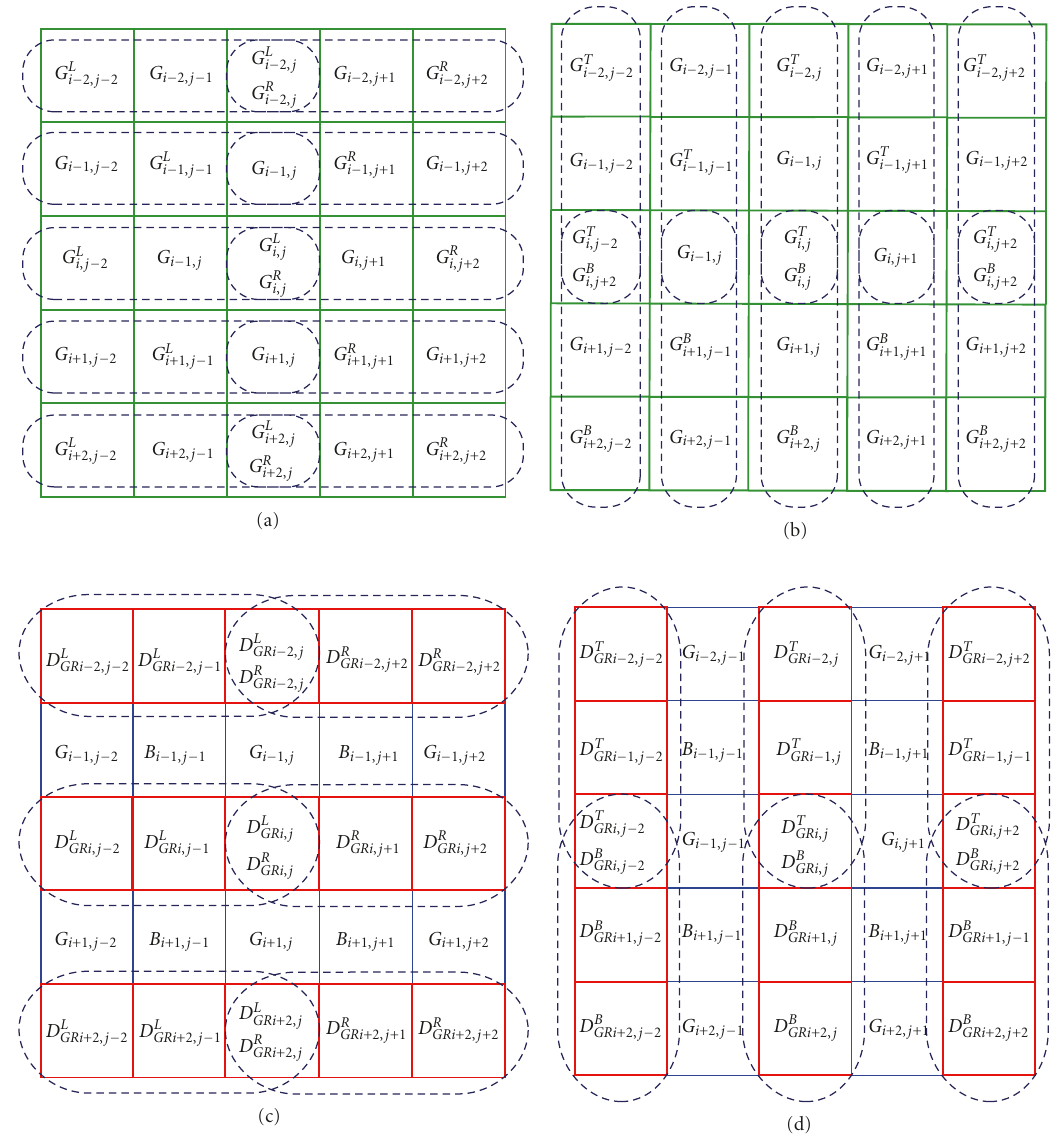
Figure 11: Pattern region: (a) left and right for the G channel, (b) top and bottom for the G channel, (c) left and right for the K R channel (d), and top and bottom for the K R